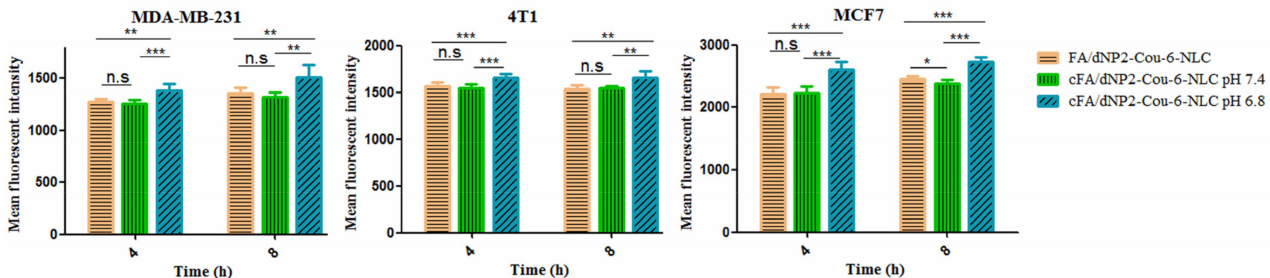
Figure 5. The cellular uptake in MDA-MB-231, 4T1, and MCF-7 cells after treatment with Cou-6-loaded different modified NLCs. * p < 0.05; ** p < 0.01; *** p < 0.001; n.s., not significant. Results are expressed as mean ± SD, n =